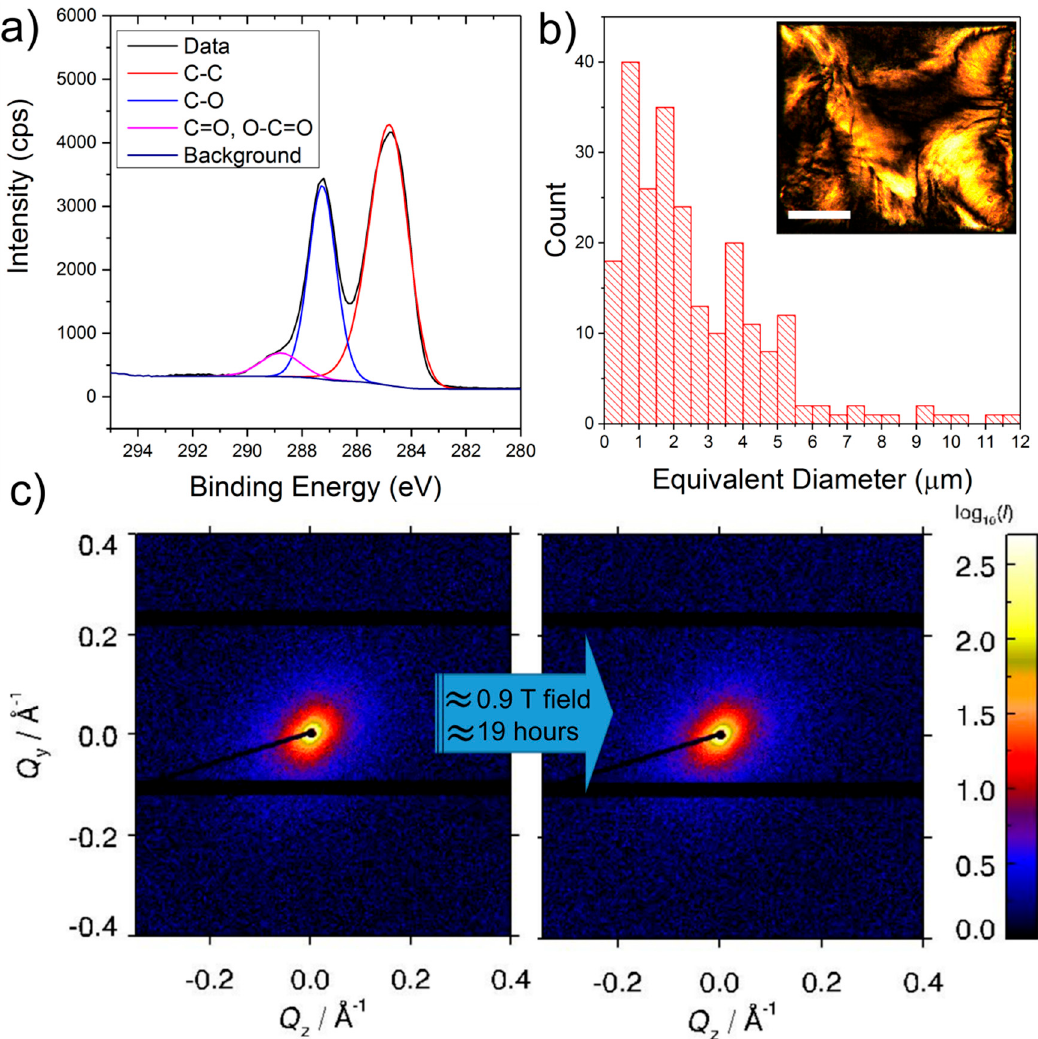
Figure 16. XPS and size distribution of the graphene oxide used in our magnetic field experiment ( a , b ). The inset shows a typical POM texture of the GO (scale of 500 µ m). ( c ) Small-angle X-ray scattering (SAXS) patterns produced by this GO at a 0.5 wt% dispersion in DMF. The magnetic field is in the horizontal direction. After leaving the sample overnight in the field, no alignment effect was observed.